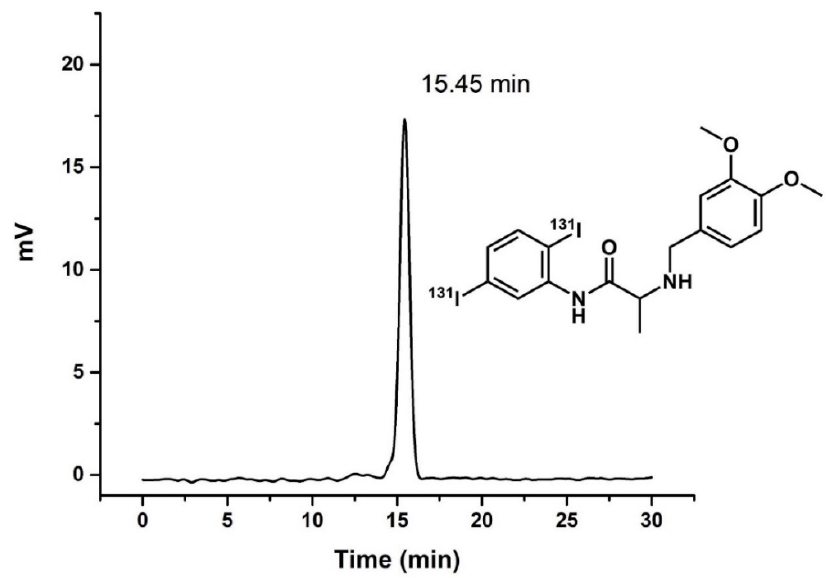
Figure 3. Reversed-phase radio-HPLC chromatogram of the 131 I-labeled C19 compound. General scheme of I-C19 structure labeled with 131 I (top-right).